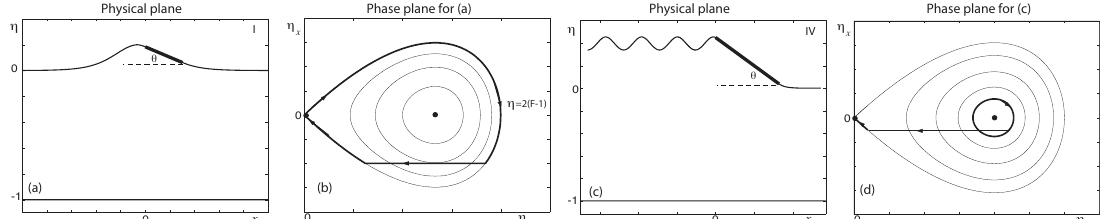
Figure 5. Flow past a flat plate of finite length L inclined at an angle θ to the horizontal, F > 1 [28]. ( a,b ) Supercritical flow type I. The solution can be viewed as a perturbation of a solitary wave; ( c,d ) Generalised hydraulic fall flow type